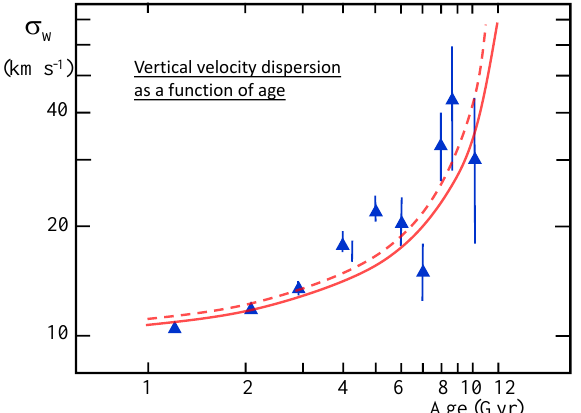
Figure 10. The vertical dispersion σ W as a function of the age of the stellar populations. The blue triangles with the error bars result from the analysis by Seabroke & Gilmore [85] of the observations by Nordstrom et al. [89]. The continuous red curve shows the predictions of the scale invariant dynamics according to relation (87) for an age of the universe of 13.8 Gyr. The broken red curve accounts for the fact that the Galaxy formed about 400 Myr after the Big Bang. A vertical dispersion of 10 km s − 1 is assumed at the present